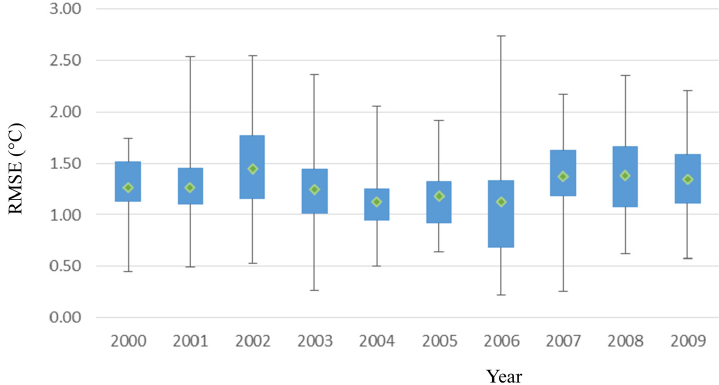
Figure 6. Root Mean Squared Errors from site-specific models for all years. Green dots are median values for the year; blue boxes are the first–third quartiles and the whiskers are the min and max